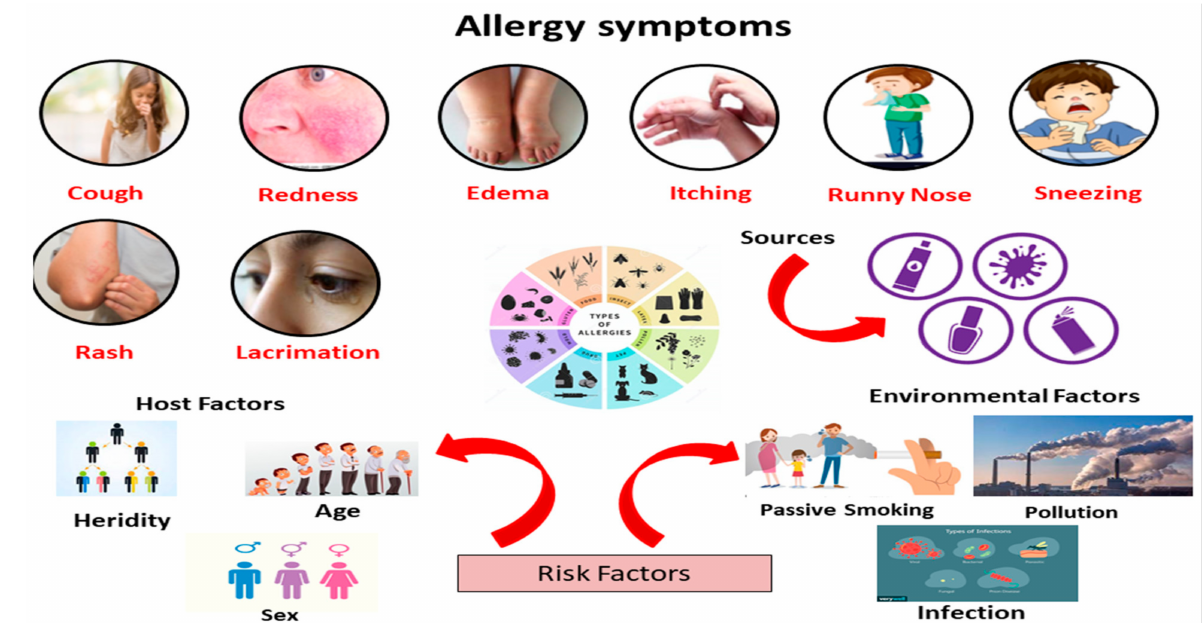
Figure 1. Symptoms and risk factors of allergic